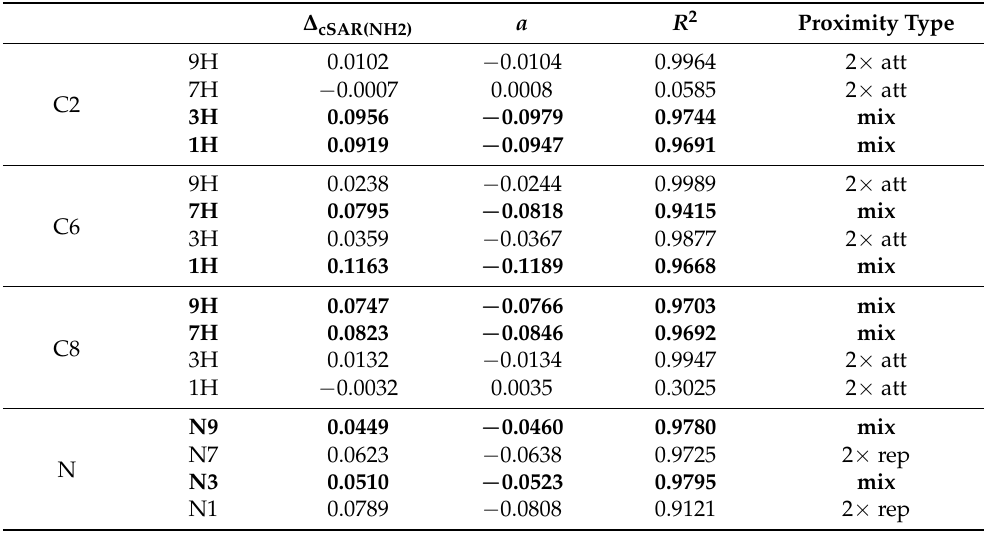
Table 2. Statistical data on cSAR(NH 2 ) = a · (1/ ε ) + b linear fitting equations for C2-, C6-, C8-, and N-NH 2 -substituted 9H, 7H, 3H, and 1H purine tautomers; ∆ is the difference between the value of cSAR(NH 2 ) in H 2 O and the gas phase. Mixed-proximity systems in bold. ∆